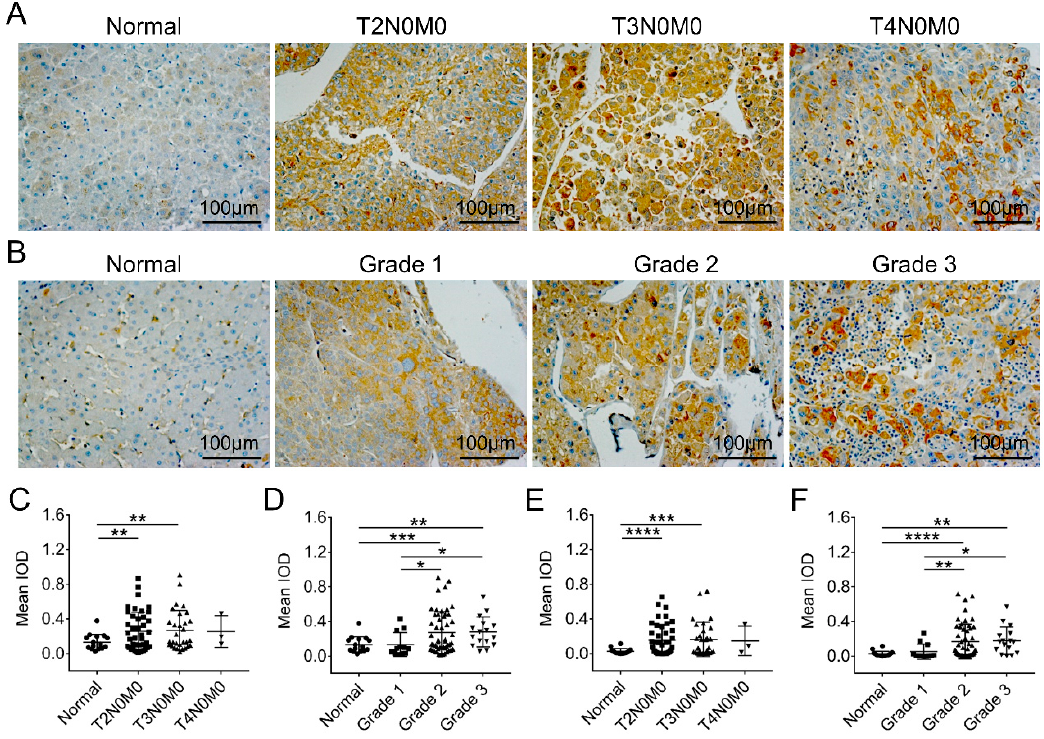
Figure 5. Human liver tissue microarray analysis for the correlation between FKBP1A protein expression level and LIHC patients depending upon TNM staging or histologic grade. ( A , B ) Representative images of human normal liver tissues and LIHC patients with T2N0M0, T3N0M0, or T4N0M0 tumors ( A ) and grade 1, 2, or 3 tumors ( B ) with FKBP1A staining. ( C , D ) Quantification of the mean optical density (mean IOD) of FKBP1A protein at different TNM stages (C) and different tumor grades ( D ). ( E , F ) Quantification of the mean IOD of FKBP1A protein distributed in the endoplasmic reticulum at different TNM stages ( E ) and in different tumor grades ( F ). The normal group includes healthy liver tissues and adjacent to LIHC tissues. Tumor grade is the description of a tumor based on how abnormal the tumor cells and the tumor tissue look under a microscope. Each point represents an individual tissue. Scale bar, 100 µ m. Data are presented as the means ± SD. * p < 0.05, ** p < 0.01, *** p < 0.001, **** p < 0.0001.